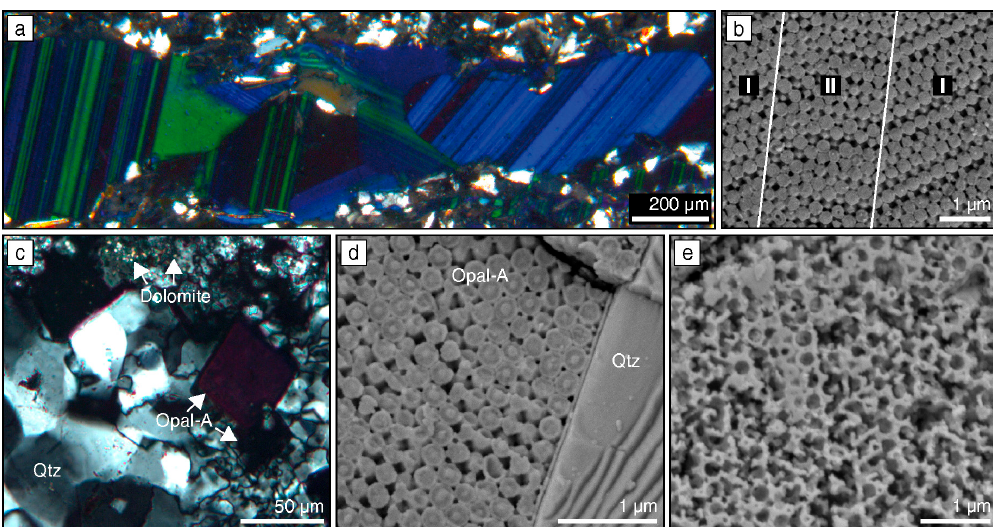
Figure 6. Optical photonic crystal pseudomorphs with precursor preservation from Andamooka. The images (b) and (d) were captured on HF-etched samples. (a) Microphotograph of fracture-filling striated photonic crystals with different colors and orientations between crossed polarizers. (b) SE image of the polished surface of a twinned crystal with alternating sphere array orientation in an I-II-I pattern. White lines highlight the interface between sphere stacks with different orientation. (c) Microphotograph of opal-A-filled rhombs in a quartz-cemented sample with ooids replaced by a mosaic of interlocked quartz crystals and dolomite. (d) SE image of the interface between precious opal-A inside rhombs and quartz on the outside as in c . (e) SE image of inverse opal-A in rhombohedral pseudomorphs.